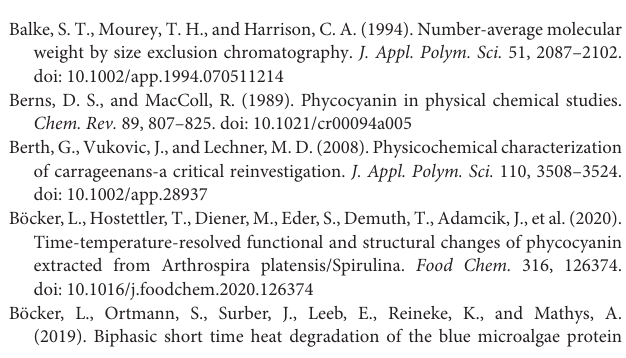
Supplementary Figure 1 | Zeta potential (mV) of PC: λ C (1:4) solutions heated to 70 or 90 ◦ C at pH 3.0 or 6.0 and unheated λ C at pH 3.0 plotted over ultrasonication treatment